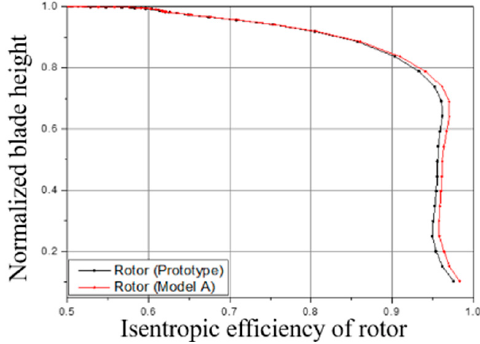
Figure 9. Isentropic efficiency of the rotor.